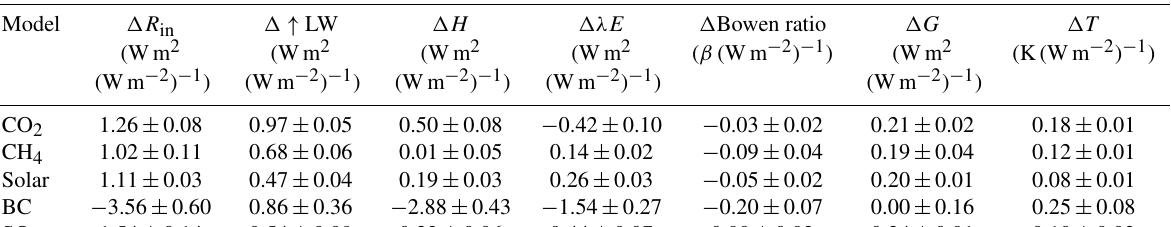
Table 2. Globally averaged multi-model mean (MMM ± 1s.e.) values of changes in surface energy components and temperature per unit of global TOA forcing.